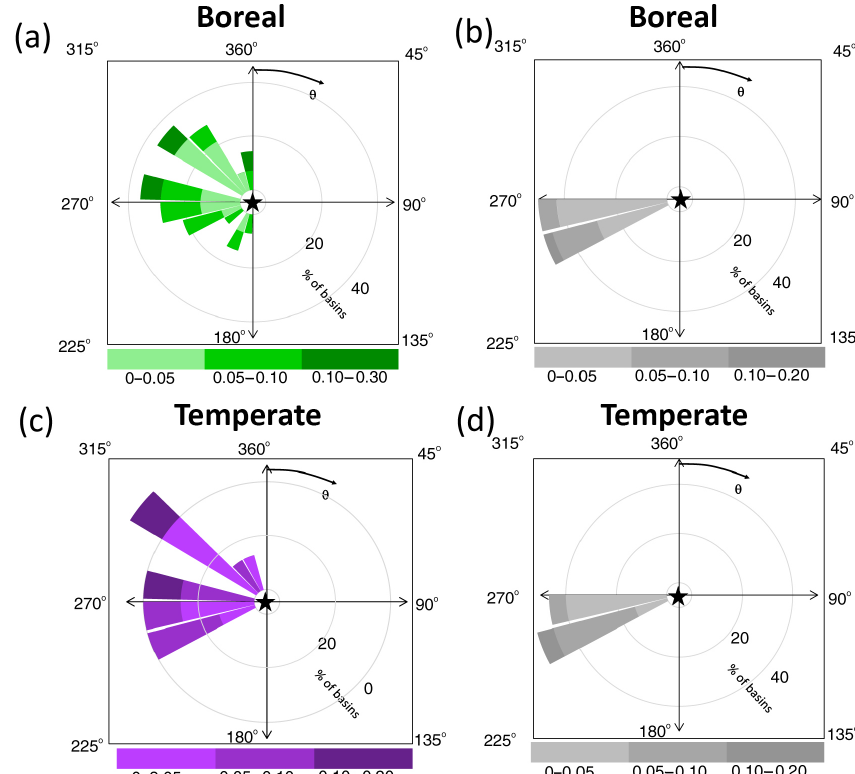
Figure 4. Hydroclimatic movement in Budyko space for the 65 basins due to changes in aridity index ( E 0 /P ) and evaporative ratio ( E/P ) between the two comparative periods 1961–1986 and 1987–2012. Wind roses of individual basin movements of the boreal basin-group according to (a) the combined effect (green) of all drivers of change by calculating E/P from runoff observations (i.e. E/P by Eq. 2) and (b) the effect (grey) of only change in the aridity index by calculating E/P from modelled data (i.e. ( E/P) c by Eq. 4), with fixed n and varying E 0 /P) . (c–d) Similar wind roses for temperate basins (purple and grey, respectively). The range of directions of movement (0 < θ < 360 ◦ ) is divided into 15 ◦ interval paddles that group all basins moving in each direction interval, with directions θ starting from the upper vertical and clockwise. We chose this 15 ◦ value arbitrarily, to provide sufficient detail of direction. Intensity of colour intervals represent the magnitude of the movement ( r ) in Budyko space in given direction θ . As an example, 37% of all boreal basins (Fig. 4a) moved in the range of directions 270 ◦ < θ < 295 ◦ . Colour intensity describes the range of magnitude ( r : –) of those movements in Budyko space. As an example, of those boreal basins moving in the range of direction previously described (37% of the boreal basins), 14% have moved with magnitudes between 0 and 0.05 (light green), 14% with magnitudes between 0.05 and 0.10 (medium green) and 9% with magnitudes between 0.10 and 0.30 (dark green). In contrast, no boreal basin moved in this range of direction (270 ◦ < θ < 295 ◦ ) when using the Choudhury equation (Fig.